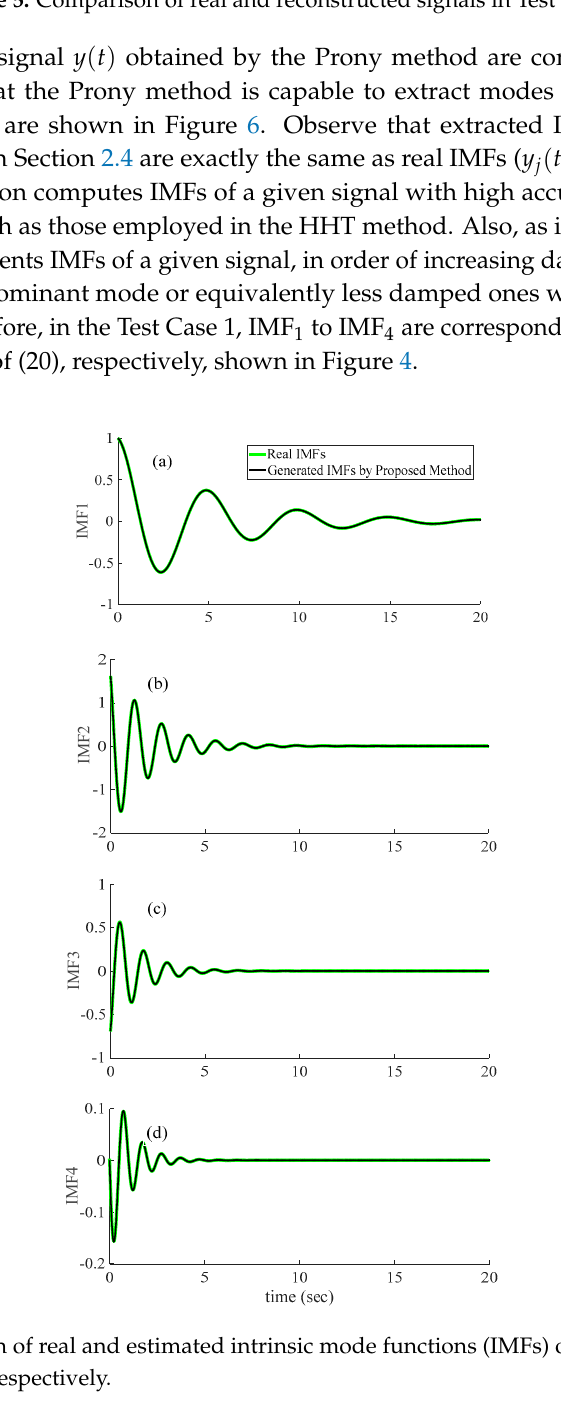
Figure 5. Comparison of real and reconstructed signals in Test Case 1.